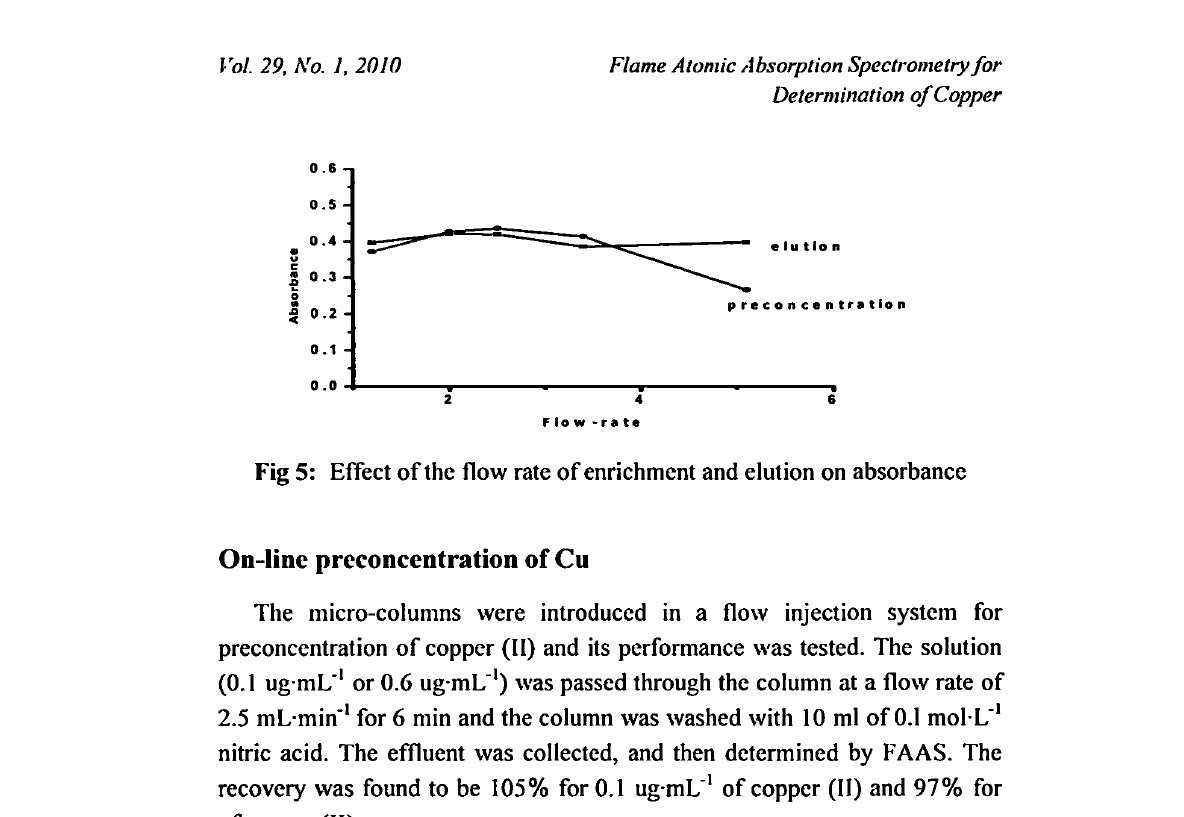
Fig 5: Effect of the flow rate of enrichment and elution on absorbance On-line preconcentration of